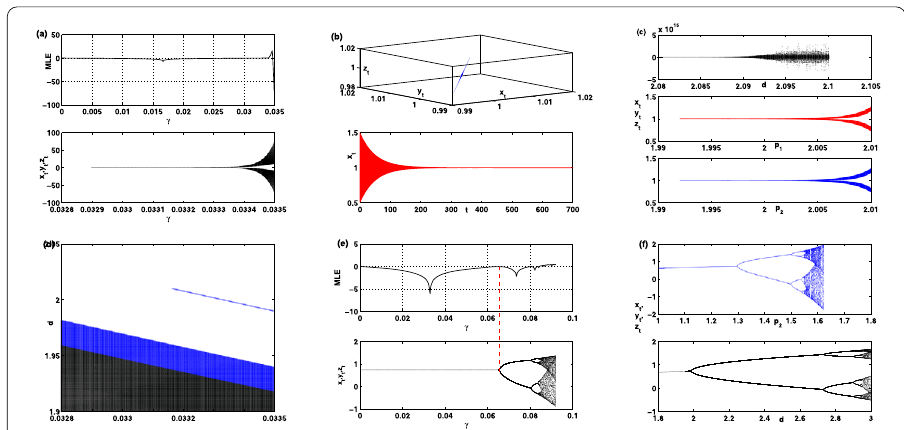
Figure 2 The complex analysis of the system (16) via bifurcations and Lyapunov exponent when varying the parameter values of γ , p 2 and d separately for the cases when p 1 = p 2 and p 1 > p